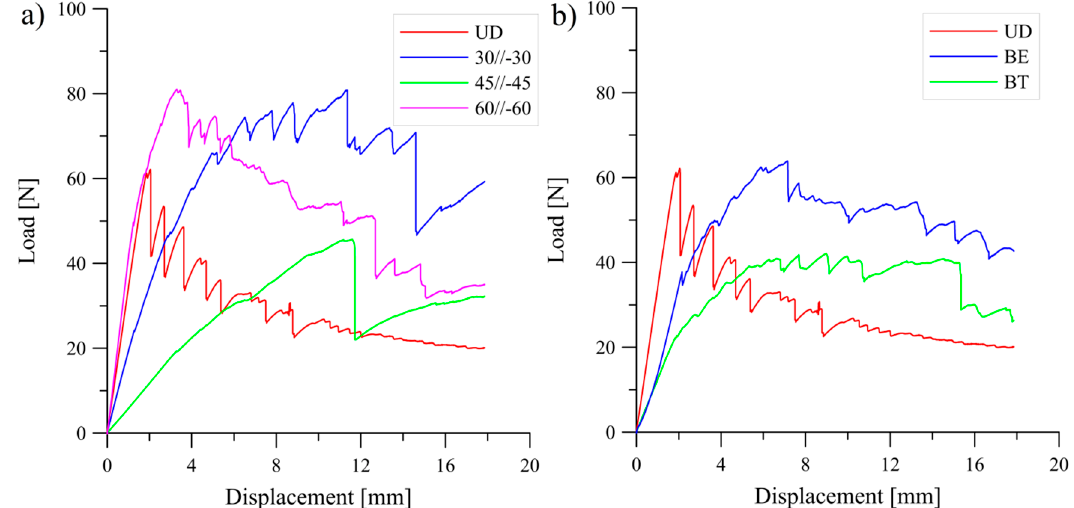
Figure 4. Load-displacement curve obtained during the DCB experiments: ( a ) for the UD and the θ // − θ laminates, ( b ) for the UD and the coupled laminates.